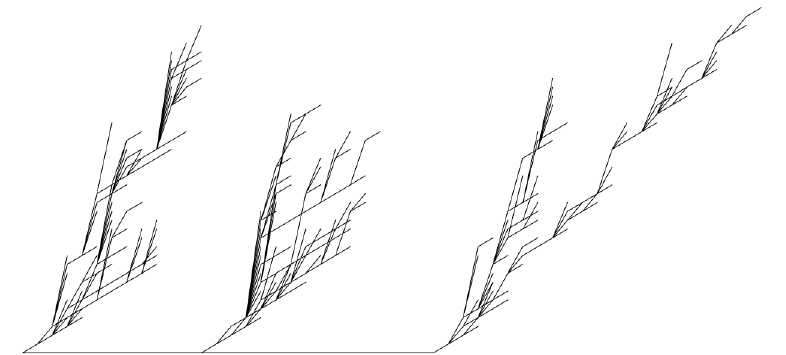
Figure 8. Graphs in a forest in which the distances are randomly determined by ¯ V − 1 . Each graph represents an excursion of ¯ X in the sense of Lukasiewicz path with a rotation for the edges of each vertex in order to obtain the (more attractive) Lichtenberg figures. The waiting time at zero gives the random distance between Lightning